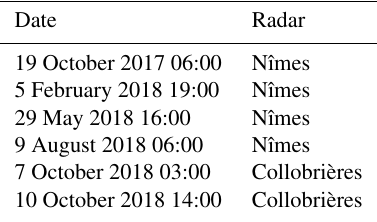
Table 1. Simulated meteorological cases used to assess simulation uncertainties. The two radars of interest operate in S-band. Times are expressed in